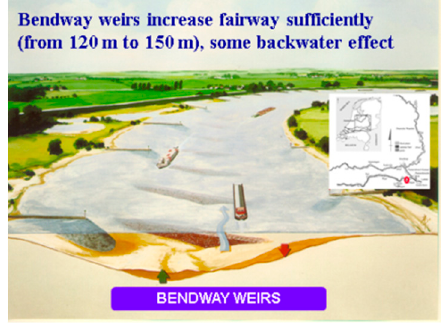
Figure 17. Bendway weirs in outer curve (copyright Kees Nuijten).